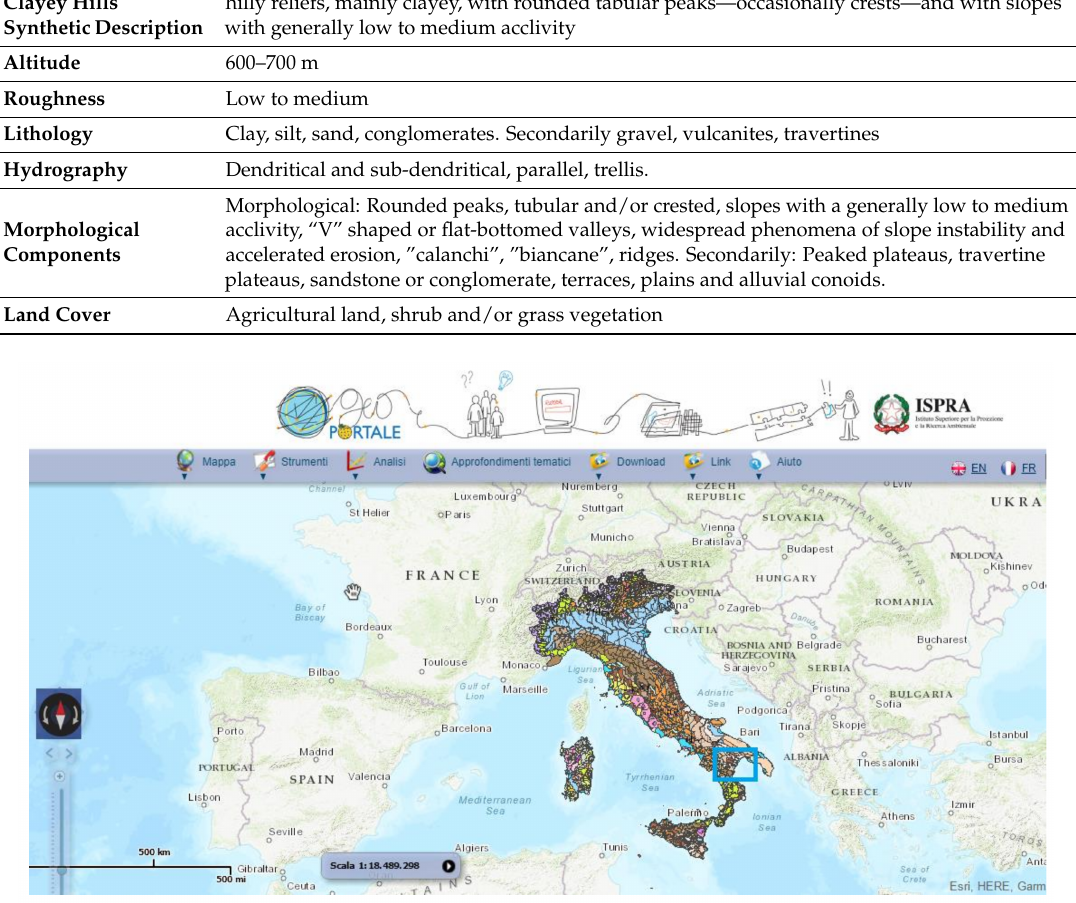
Figure 3. Landscape units map (http://www.geoviewer.isprambiente.it/). In the box, the area of interest.